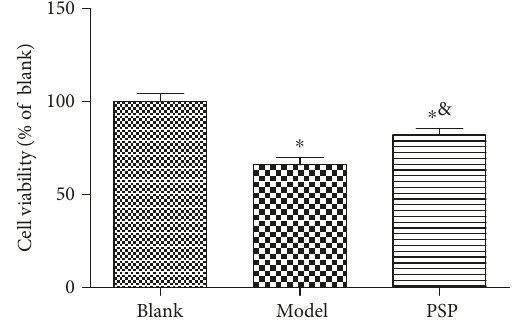
Figure 7: E ff ect of PSP on the activity of NPCs in rats with degeneration of the intervertebral disc.